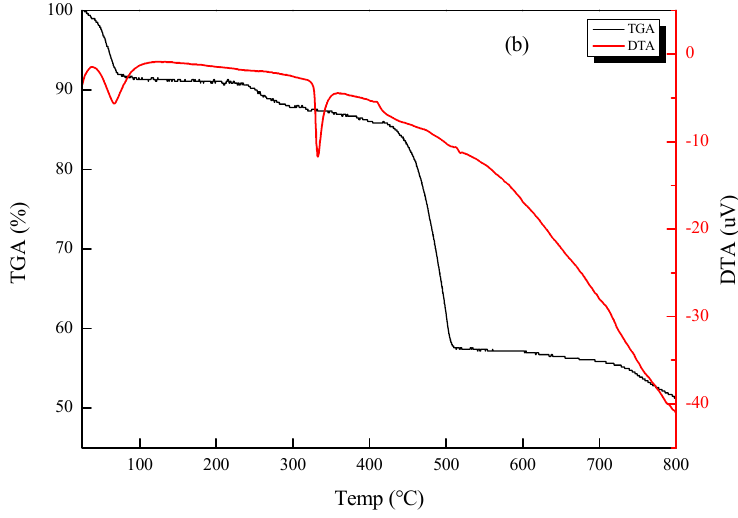
Figure 2. TGA and DTA curves of CSNPs.